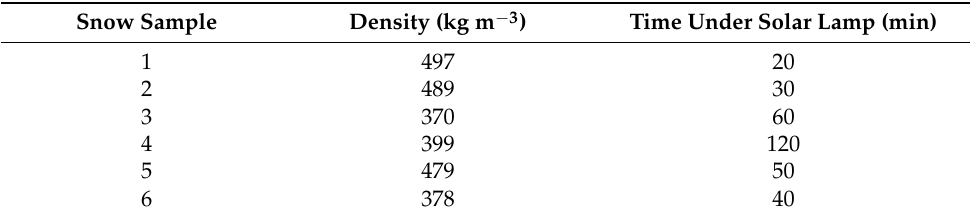
Table 1. Snow sample properties. Snow Sample